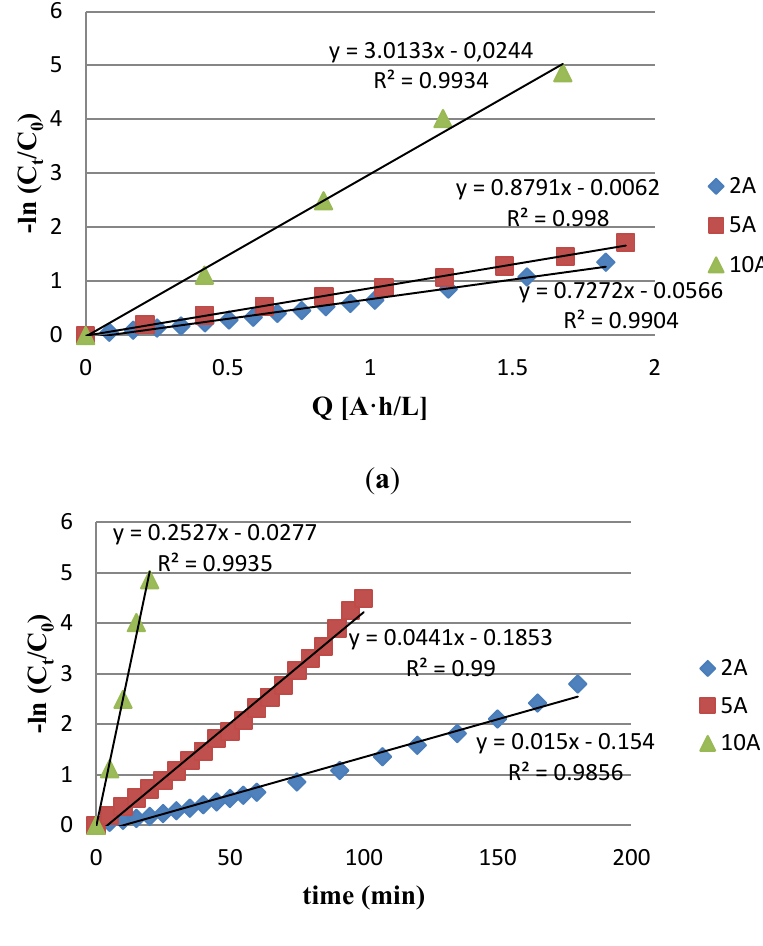
Figure 1. Procion Navy HEXL (PN) Decolorization with electrochemical treatments at 2 A, 5 A and 10 A. ( a ) PN kinetic rate in time; ( b ) PN kinetic rate in applied charge; ( c ) Evolution of PN